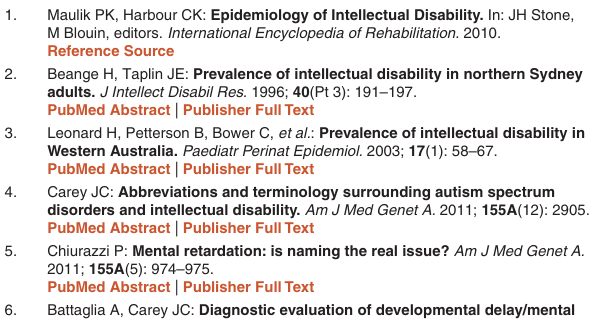
Supplementary Table 1 - OMIM terms search results. Click here to access the data. Supplementary Table 2 - ID Genes identified through OMIM and NCBI Gene. Click here to access the data. Supplementary Table 3 - DAVID analysis of ID genes. Click here to access the data. Supplementary Table 4 - gProfiler analysis of ID genes. Click here to access the data. Supplementary Table 5 - DAVID and REVIGO analysis of genes with Brain Ratio above 2. Click here to access the data. Supplementary Table 6 - DAVID and REVIGO analysis of genes with Fetal Brain Ratio above 2. Click here to access the data. Supplementary Table 7 - gProfiler analysis of genes with Brain/Fetal Brain Ratio above 2. Click here to access the